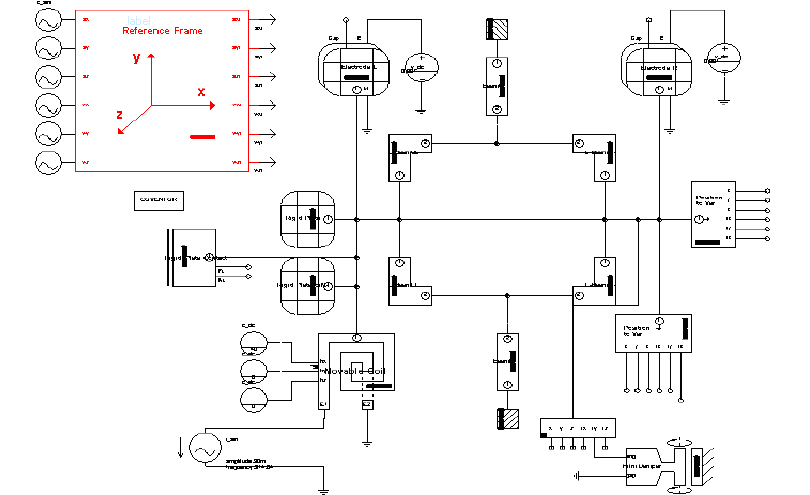
Figure 5. Simulation structure of the magnetometer with